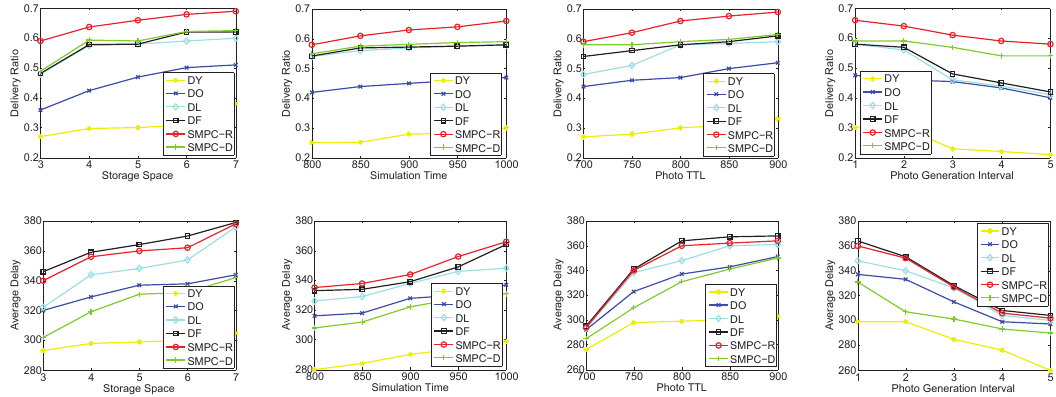
Figure 13. Performance comparisons on the roma/taxi trace set : delivery ratio and average delay.